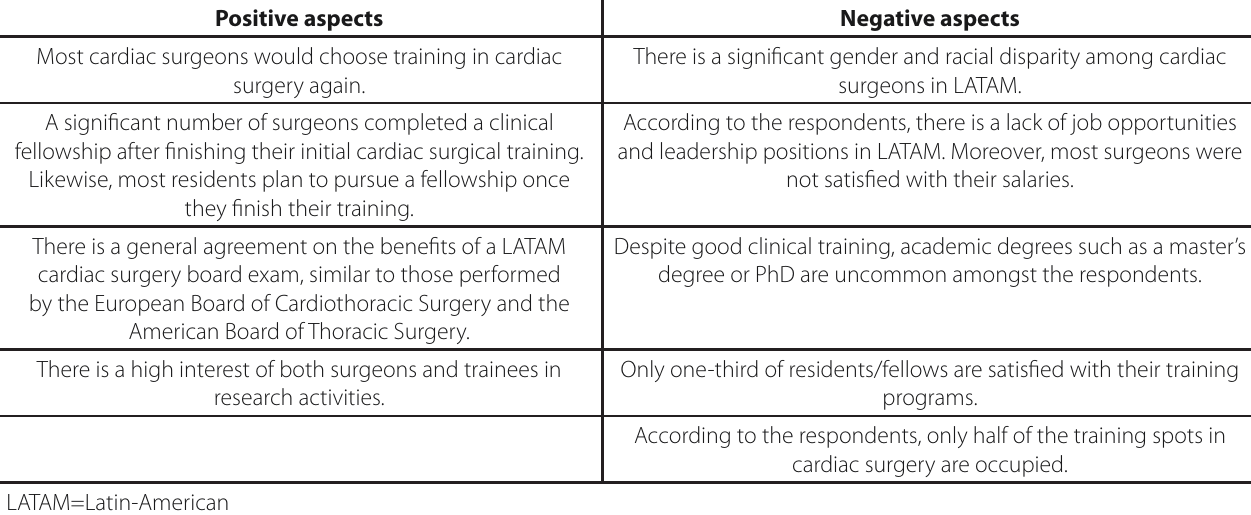
Table 3. Main survey